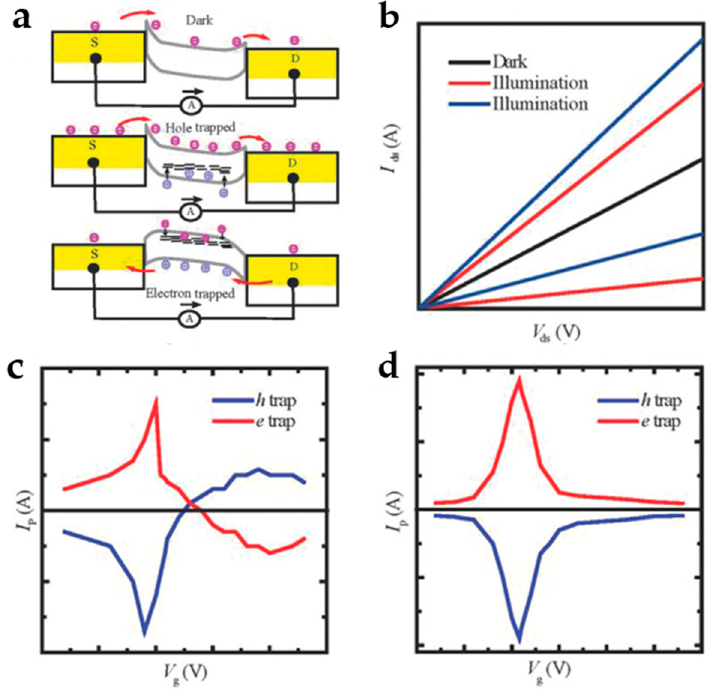
Figure 4. ( a ) Schematic of PG e ff ect in the dark state in the upper panel, hole trap in the middle panel, and electron trap in the bo tt om panel. ( b ) I − V curves in dark and illuminated states. ( c , d ) Photocurrent as a function of gate voltage for ambipolar and unipolar FET devices, respectively. (Reprinted with permission from ref. [5]. Copyright 2018 John Wiley and Sons Publications) .